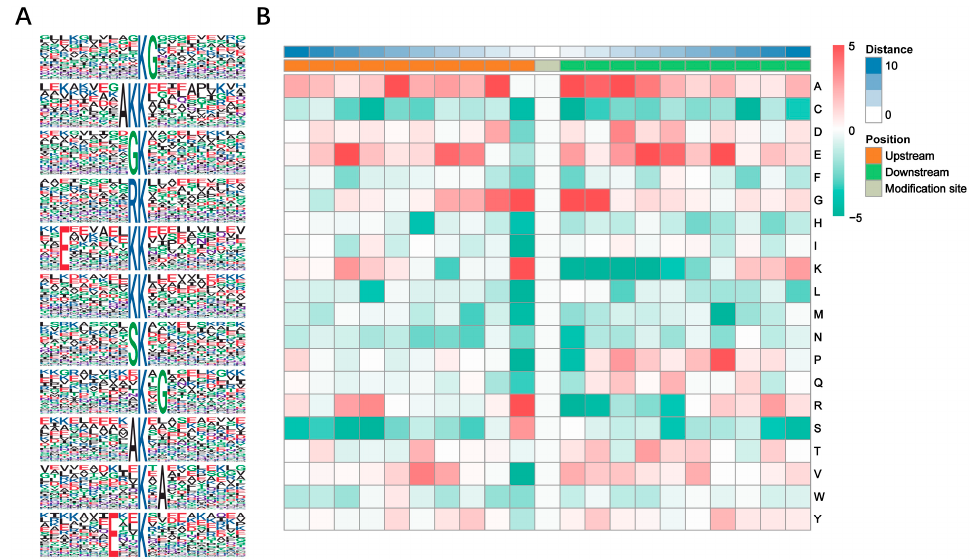
Figure 2. Sequence analysis of the ubiquitinated proteins. ( A ) Enriched ubiquitination motif logos generated by Motif-x. Letters with higher size represent higher frequency of amino acid residues. The central K refers to the ubiquitinated lysine. ( B ) Heat map of the amino acids up- and down-stream of central Kub